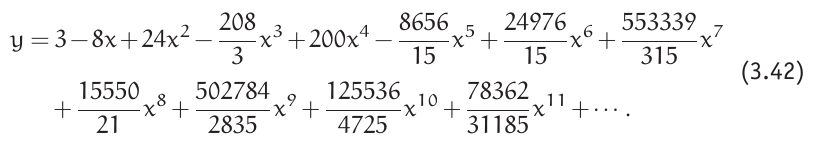
Table 3.3 gives the absolute and relative errors of the infinite series approx- imation using six iterations of the Laplace transform decomposition tech- nique. The error is less than 0.025 % . As in Example 3.1 , it was noticed that for large values of x , replacing the infinite series solution (3.42) with its Pade´ approximant (3.43) will improve the